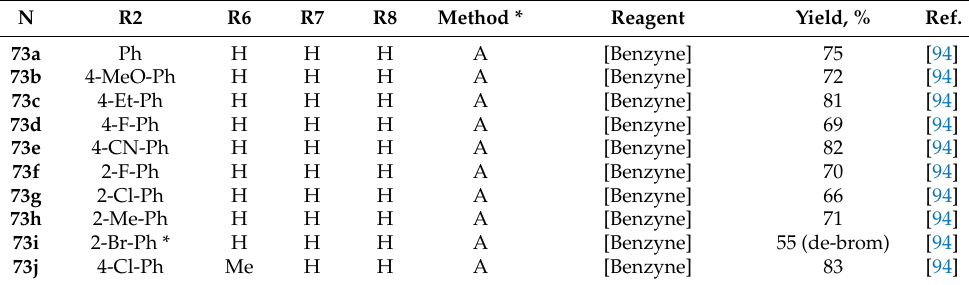
Table 19. Substituents and yields of reaction of imidazopiridines and benzynes (Scheme 37).